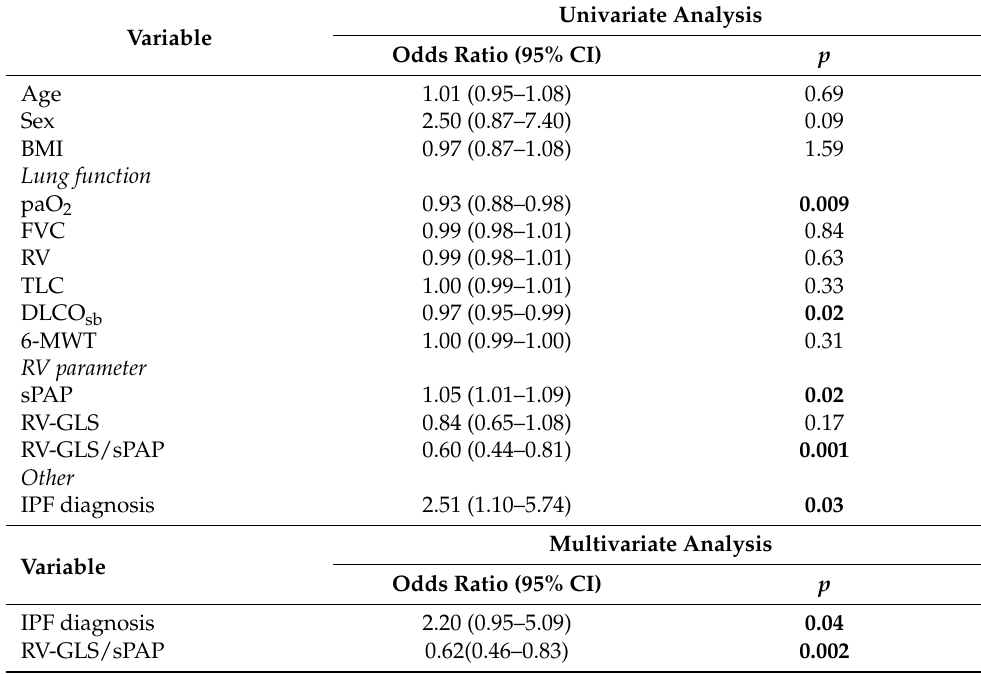
Table 3. Logistic regression analysis.